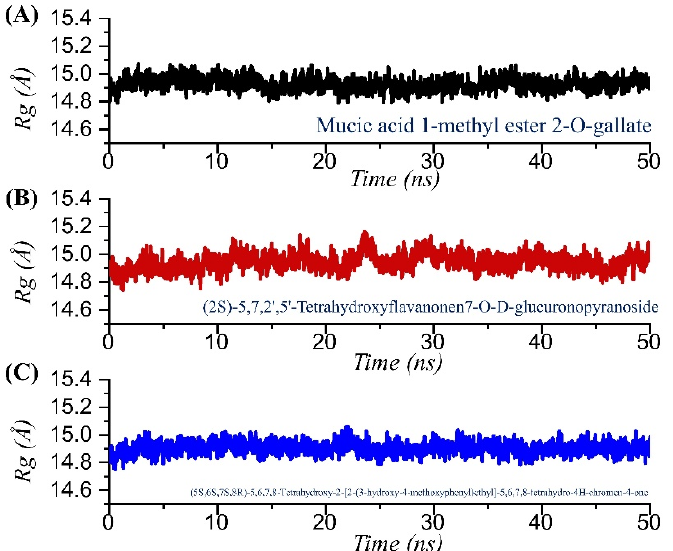
Figure 6. Structural compactness analysis in a dynamic environment of the TCM42798, TCM47007, and TCM30675 complexes calculated as Rg. ( A ) The Rg graph for mucic acid 1-methyl ester 2-O-gallate. ( B ) The Rg graph for TCM47007 or (2S)-5,7,2’,5’-Tetrahydroxyflavanone 7-O--D-glucuronopyranoside. ( C ) The Rg graph for TCM30675 or (5S,6S,7S,8R)-5,6,7,8-Tetrahydroxy-2-[2-(3-hydroxy-4-methoxyphenyl)ethyl]-5,6,7,8-tetrahydro-4H-chromen-4-1 complex.